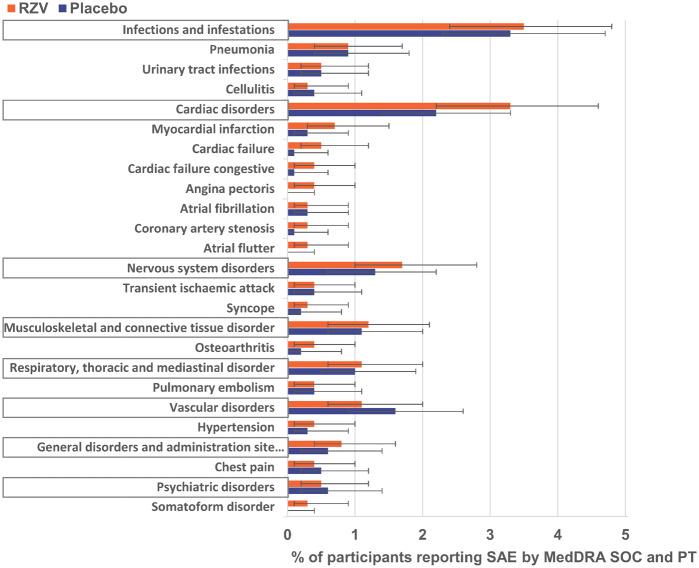
SAEs in participants with pre-existing pIMDs reported through 365 days post-last vaccine dose (TVC)SAEs by MedDRA SOC (framed) and PT are presented here. Per PT, only SAEs reported by ≥0.3% of RZV recipients are presented here. Error bars represent 95% CI. MedDRA: Medical Dictionary for Regulatory Activities; pIMD: potential immune-mediated disease; Placebo: participants receiving placebo; PT: preferred term; RZV: participants receiving the adjuvanted recombinant zoster vaccine; SAE: serious adverse event; SOC: system organ class; TVC: total vaccinated cohort; YOA: years of age.